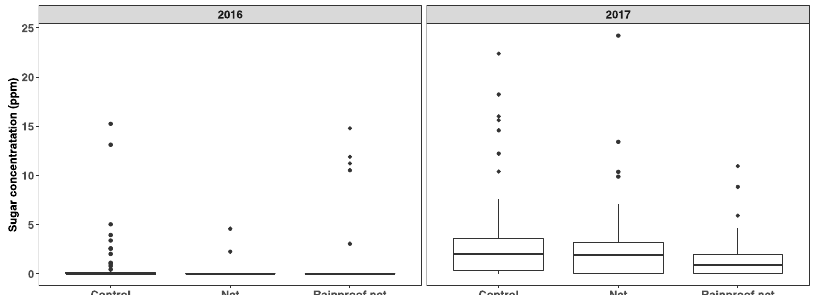
Figure 3. Sugar concentration at harvest on the surface of fruits from row units covered. With nets or rainproof nets compared to unnetted row units. The mid horizontal bar of the box represents the median, the two hinges correspond to the 25th and 75th percentiles. Whiskers extend 1.5× above and below the interquartile range. Data beyond the end of the whiskers were plotted individually.